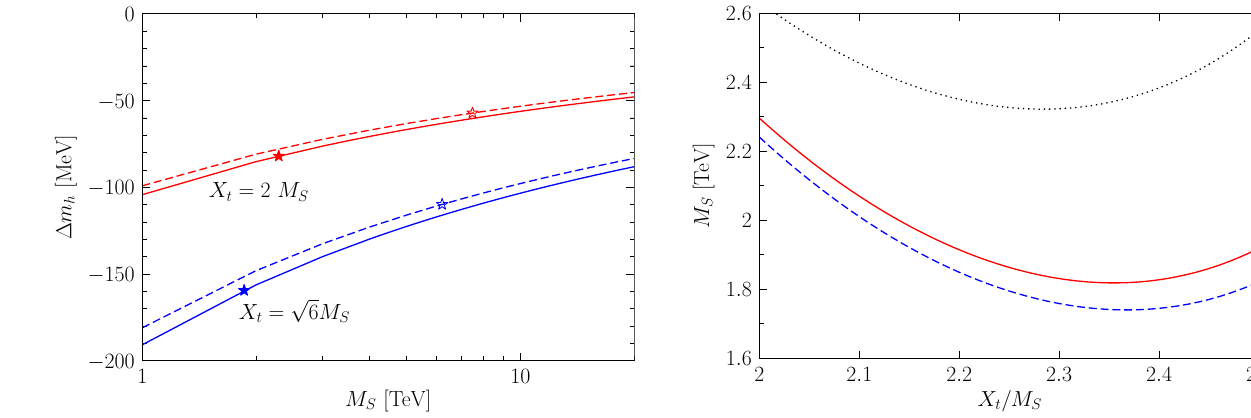
Fig. 2 Difference(inMeV)betweenthepredictionsfortheHiggsmass Fig. 3 Values of the common SUSY scale M S and of the stop mixing obtained with and without the inclusion of the mixed QCD–EW correc- term X t that lead to m h = 125 . 09 GeV, for tan β = 20 and A b = A τ = A t . The dotted line is obtained including only the one-loop threshold tions to the quartic Higgs coupling, as a function of a common SUSY √ scale M S , for X t = corrections to the Higgs quartic coupling, the dashed line includes the 6 M S (lower, blue lines) or X t = 2 M S (upper, two-loop corrections in the gaugeless limit, and the solid line includes red lines), and A b = A τ = A t . In each set of lines the solid one is also the effect of the mixed QCD–EW obtained with tan β = 20 and the dashed one with tan β = 5. The star on each line marks the value of M S for which the improved calculation of (cid:4)λ 2 (cid:5) leads to m h = 125 . 09 GeV